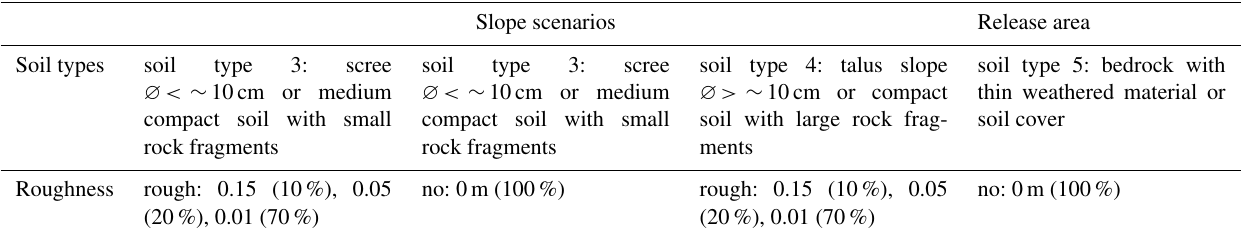
Table 1. Soil types and roughness used for the different simulation scenarios according to the classification of Dorren (2015). The release area and the forest road were set to no roughness and soil types 5 and 7, respectively, in all scenarios.